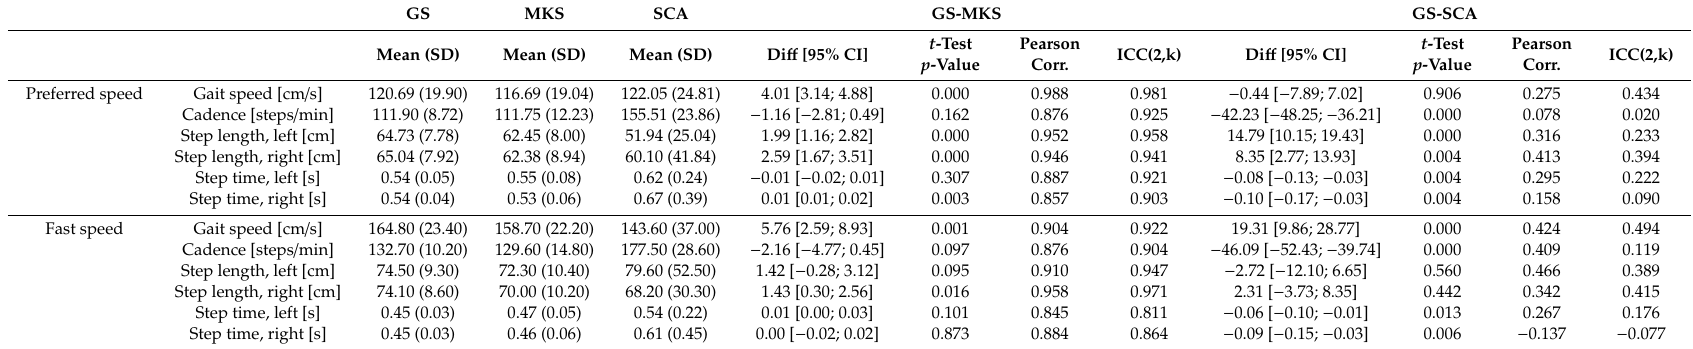
Table 2. Mean di ff erence, SD of the di ff erences, 95% confidence interval, and t-test values for GS and MKS and GS and SCA at preferred and fast